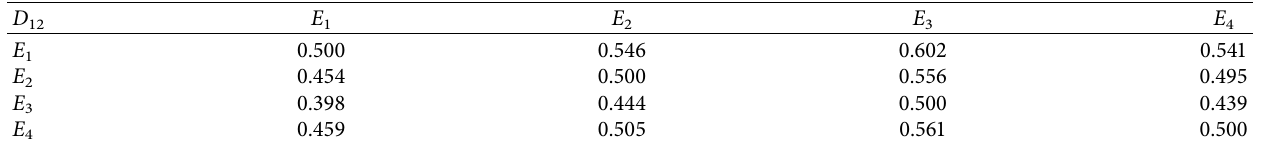
Table 8: D 12 - E priority relationship matrix.